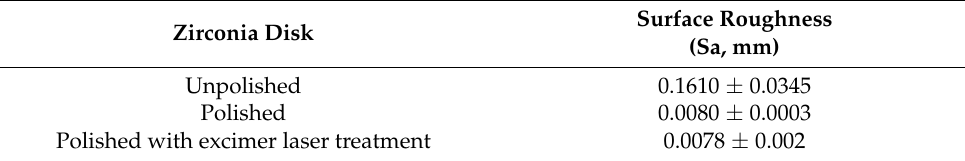
Table 1. Surface roughness values of zirconia disks. Data represent means ( ± SD). Zirconia